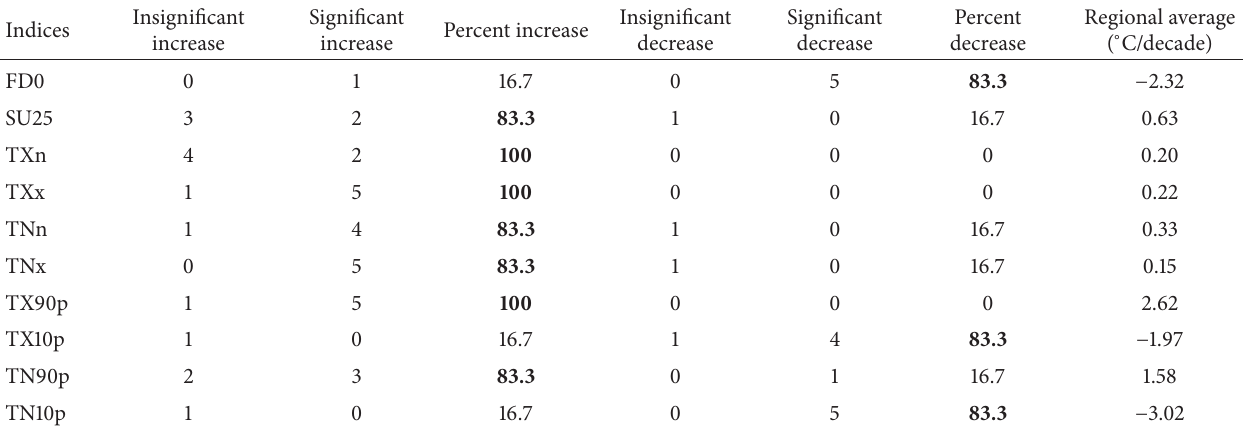
Table 4: Trend and regional averages of temperature extreme indices.